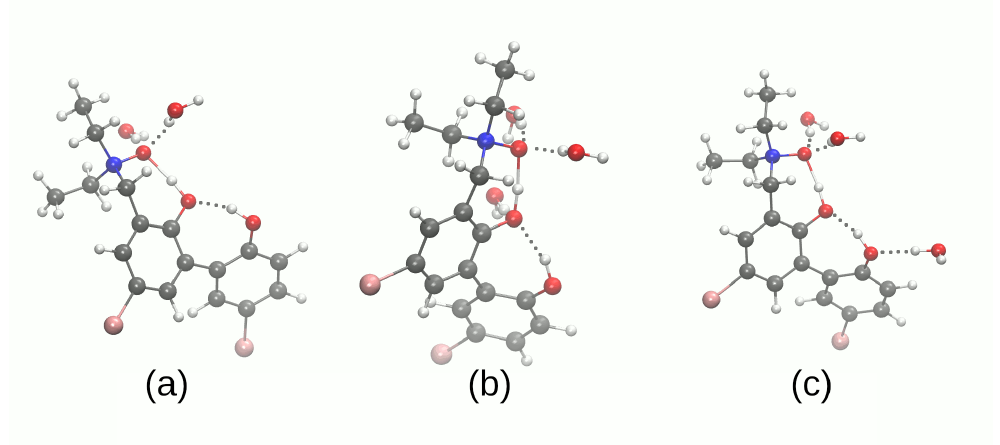
Figure 6. Microsolvation models of the compound 2 . ( a ) two water molecules on the O1 (acceptor atom) side, 2 -A2; ( b ) two water molecules on the O1 acceptor side and one water molecule on the O2 donor side, 2 -A2D A ; ( c ) two water molecules on the O1 acceptor side and one water molecules on the O3 donor side, 2 -A2D B